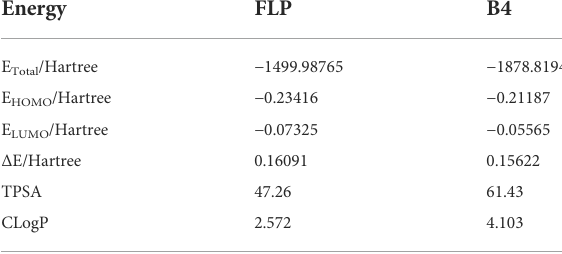
TABLE 3 Total energy and frontier orbital